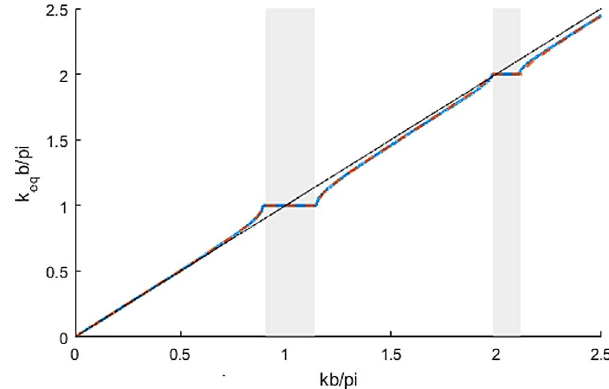
variable linear density. Blue curve: sinusoidal density fl uctuation with Dl s = 0.5 . Dotted orange curve: square density fl uctuation ffiffi q 2 . Black line: uniform string ( k eq = k with with (cid:1) l ¼ 0 : 5 ffiffiffiffi q p T k ¼ ). Grey bars: stop bands. l 0